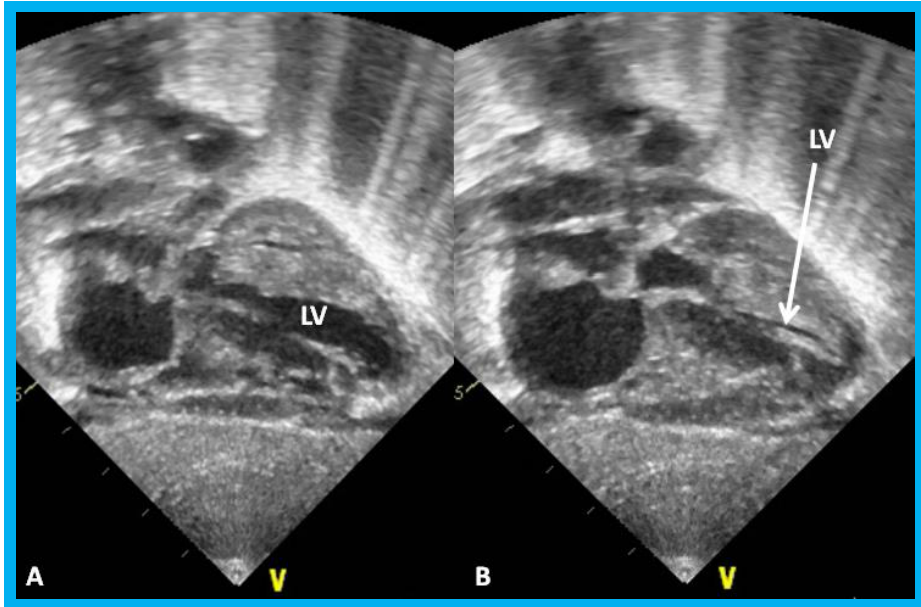
Figure 26. A and B . Subcostal views of the left ventricle (LV) in an infant of a diabetic mother showing complete obliteration of the LV cavity in systole (arrow in B ).